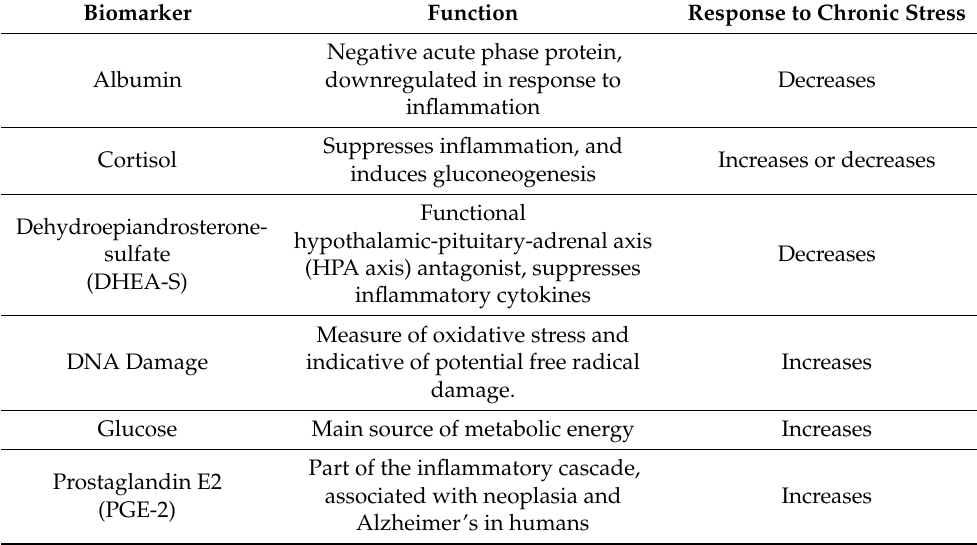
Table 1. Biomarkers used in the estimation of allostatic load for in ring-tailed lemurs ( Lemur catta ) and the response of the biomarkers to chronic